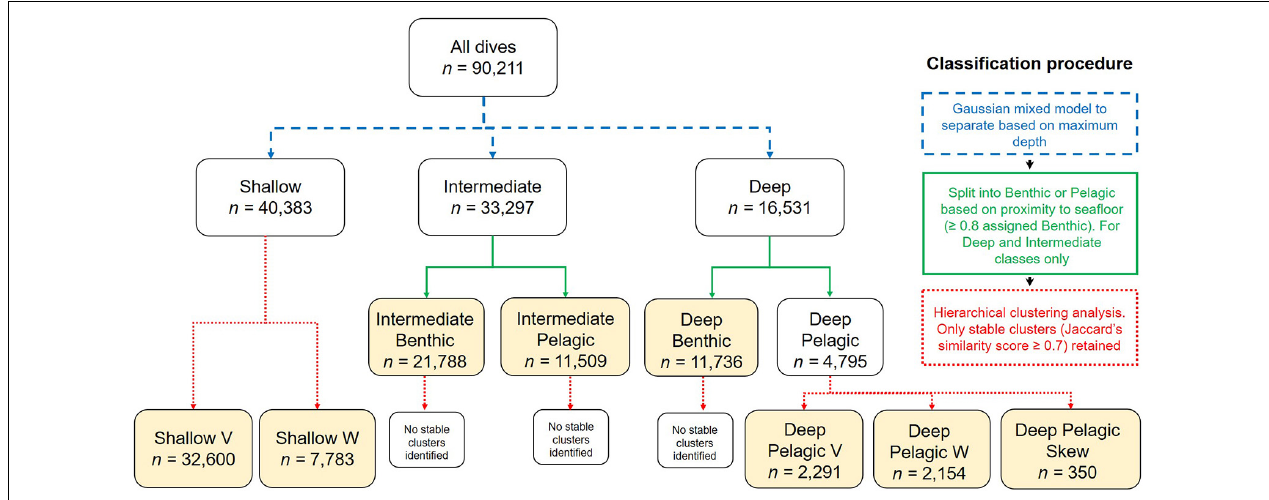
FIGURE 2 | Flow chart of the mixed classification procedure for differentiating between beluga dive types. Arrow color denotes method of classification used at each stage; step 1 = blue, step 2 = green, step 3 = red. Yellow boxes denote the final dive types